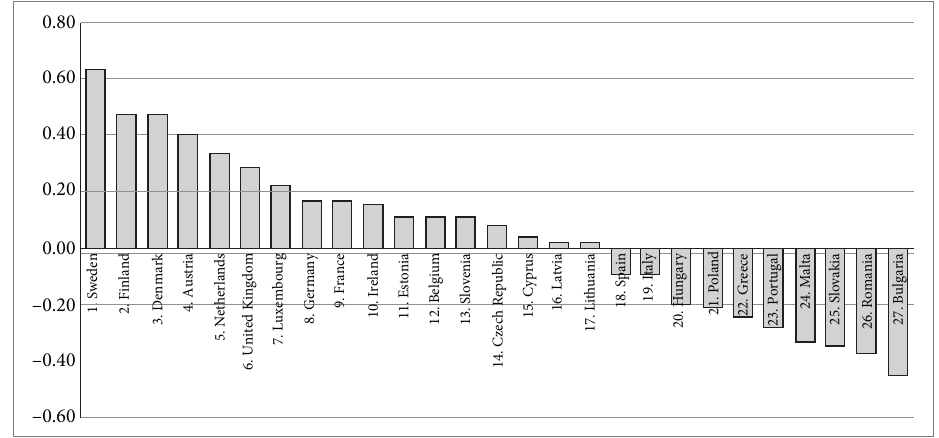
Fig. 3. Indexes and ranks of European Union Member States according to the ratio system,